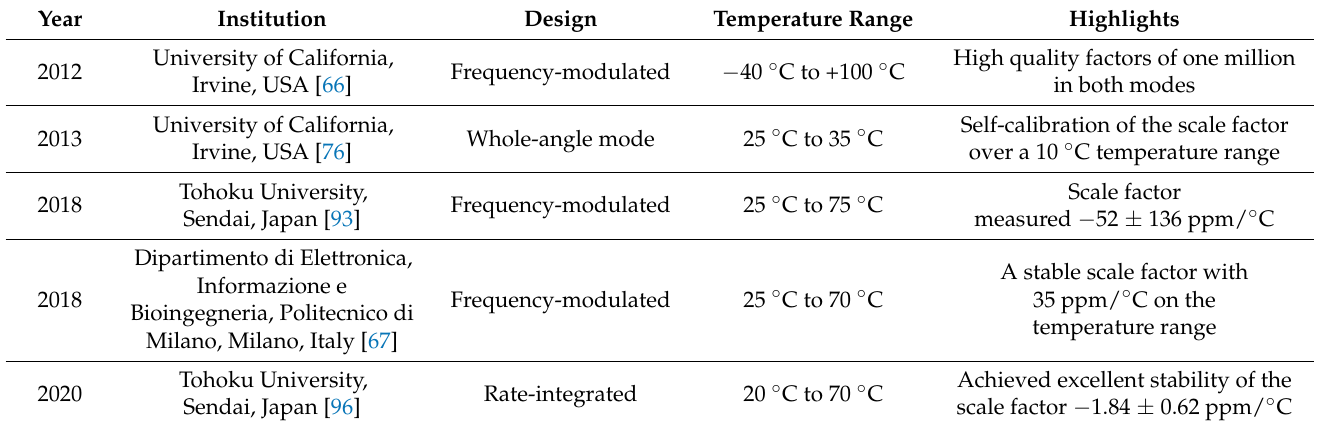
Table 3. Study of the effect of temperature characteristics on frequency-modulated and rate-integrated